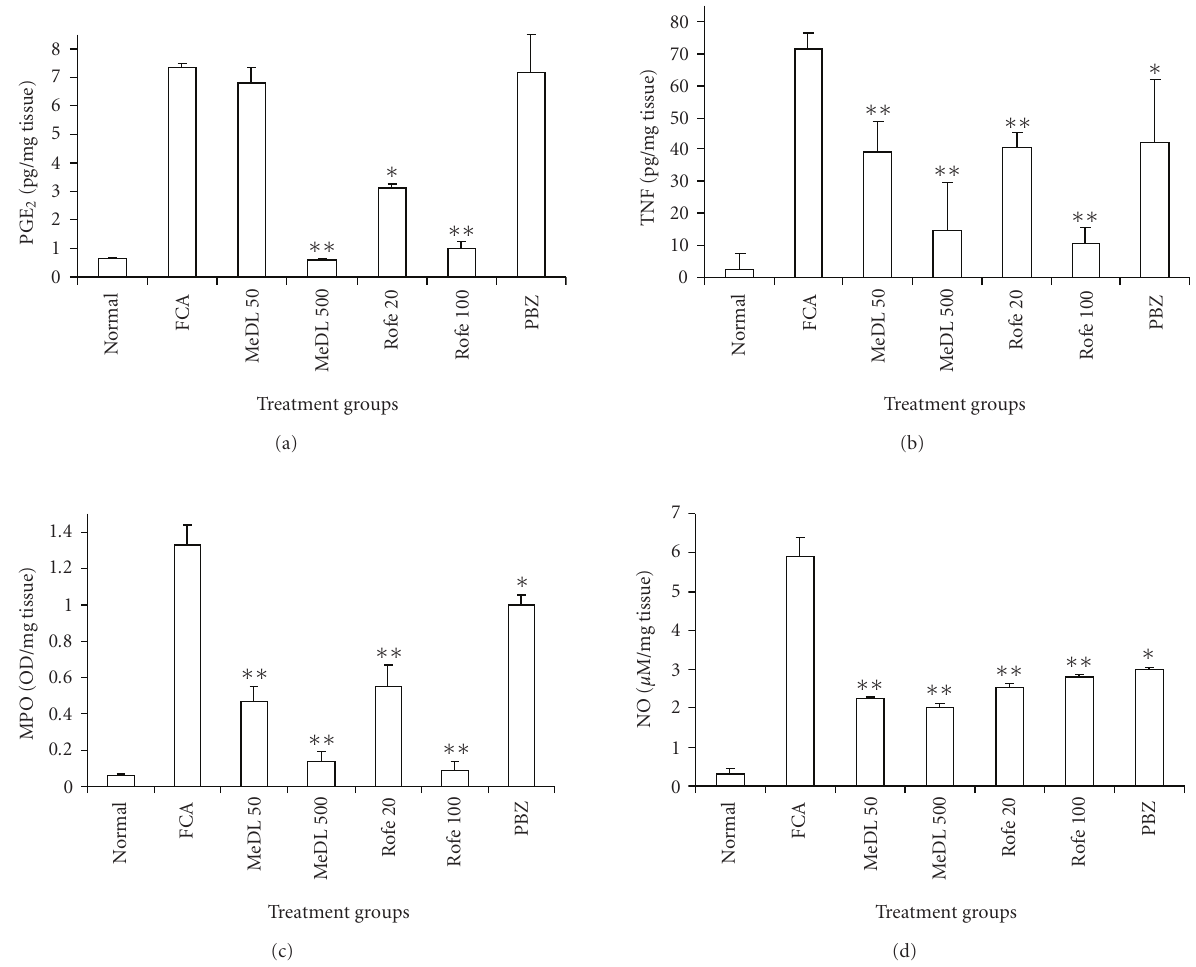
Figure 2: E ff ect of drugs on the tissue level of PGE 2 , TNF- α , MPO, and NO in FCA-induced monoarthritis in rats. Values are mean ± SEM. ∗ P < 0 . 05, ∗∗ P < 0 . 001.